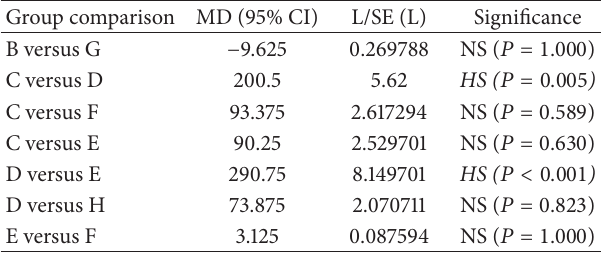
Table 3: Tukey multiple comparisons test between selected